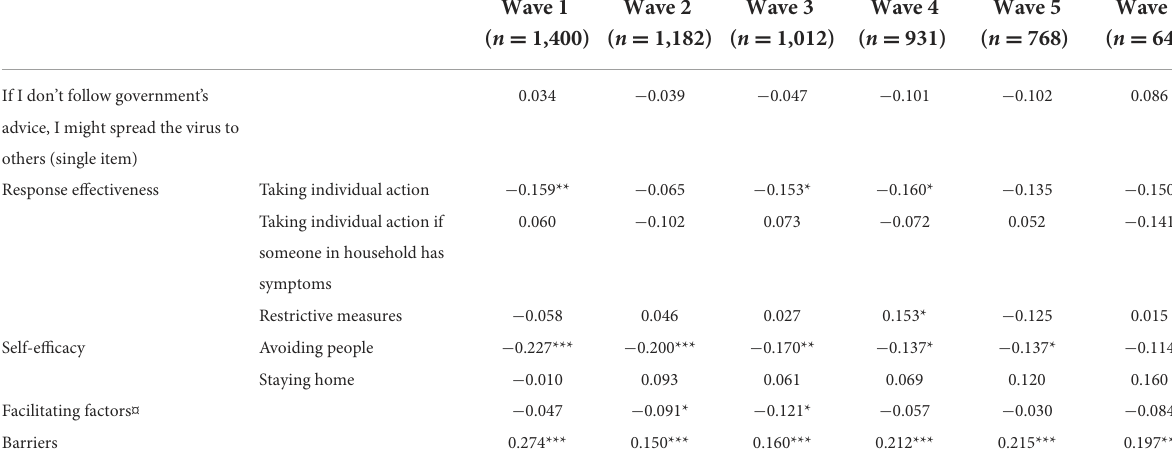
TABLE 6 Visited crowded places by cognitive predictors and facilitating factors and